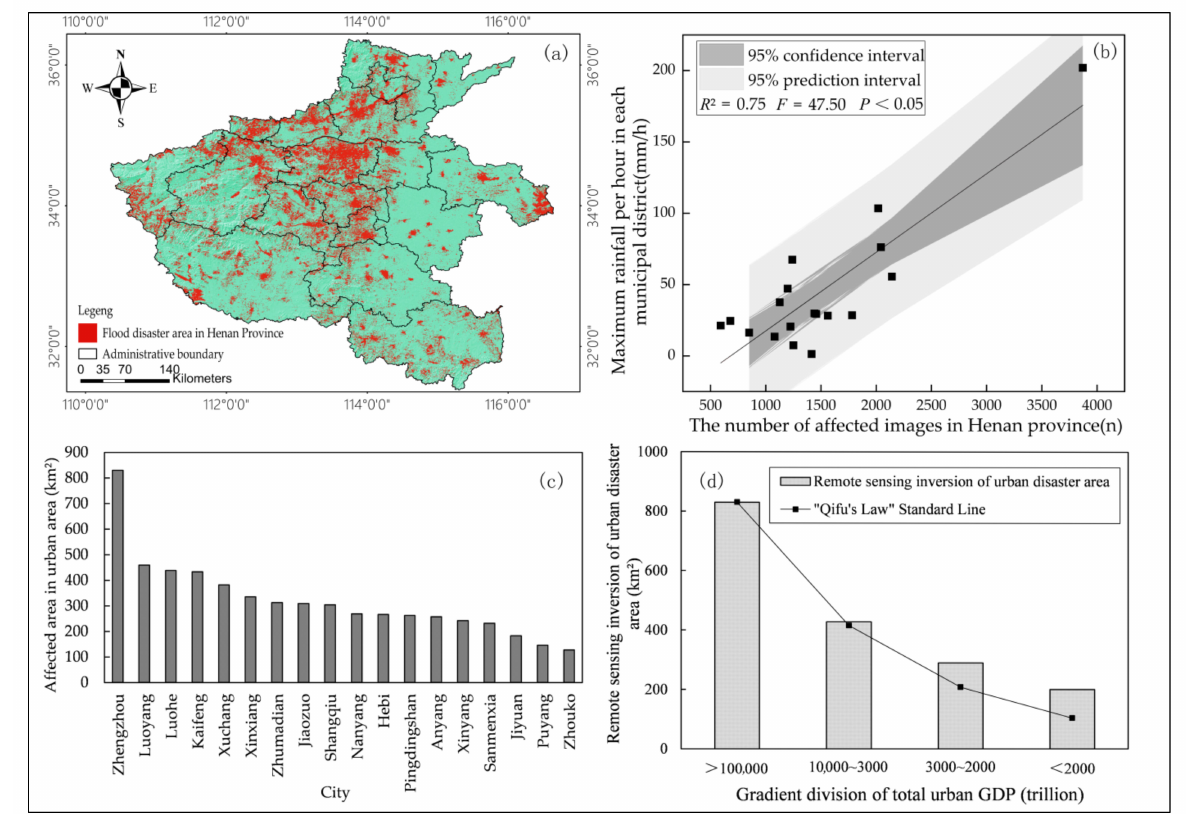
Figure 5. Analysis of disaster distribution in urban flood areas retrieved by remote sensing: ( a ) MODIS remote sensing inversion of flood disaster distribution map; ( b ) Regression model of flood disaster area and maximum rainfall in Henan; ( c ) Extraction of flood disaster areas in the directly administered areas of Henan Province from remote sensing images; ( d ) Zipf’s law map of urban disaster area in Henan